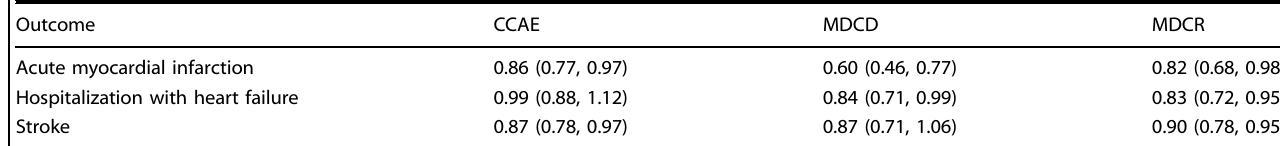
Table 3. Relative effect estimates. Hazard ratio estimates for the overall treatment effect of thiazide or thiazide-like diuretics compared to ACE inhibitors. Values in brackets are 95% con fi dence intervals.